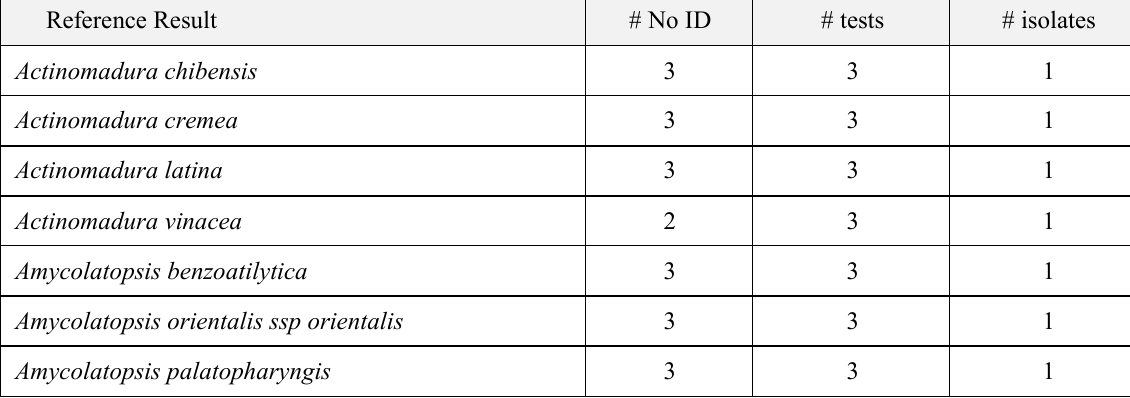
TABLE 5: Actinomadura and Amycolatopsis species tested;VITEK MS result ‘No Identification’ Reference Result